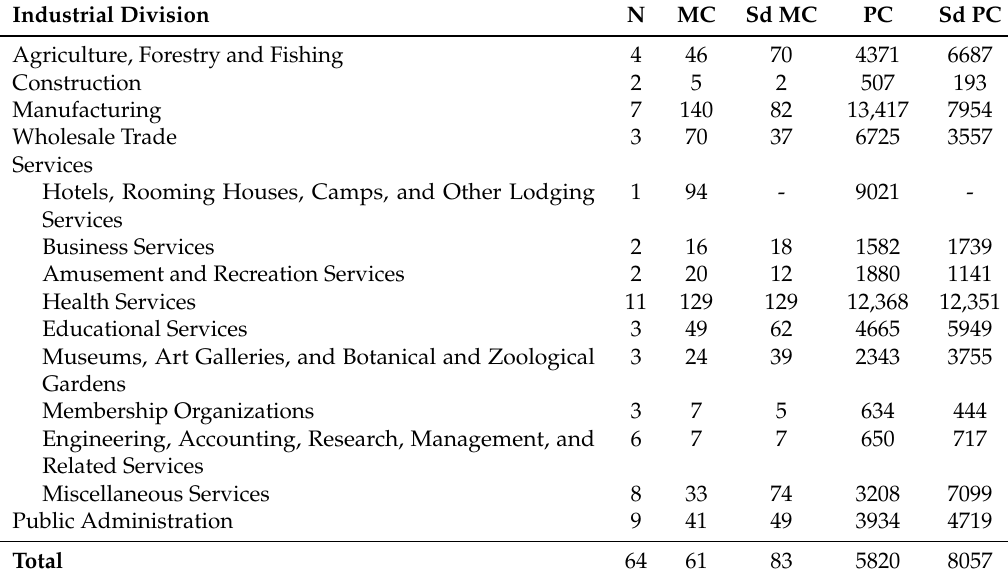
Table 1. Summary of the customers present in our dataset grouped by industrial division .